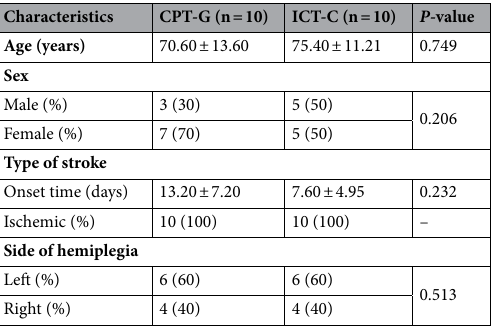
Table 1. Demographic and clinical characteristics of the patients (N = 20). CPT-G conventional physical therapy and gait training, ICT-C ankle–knee–hip interlimb coordinated humanoid robot combined with conventional physical